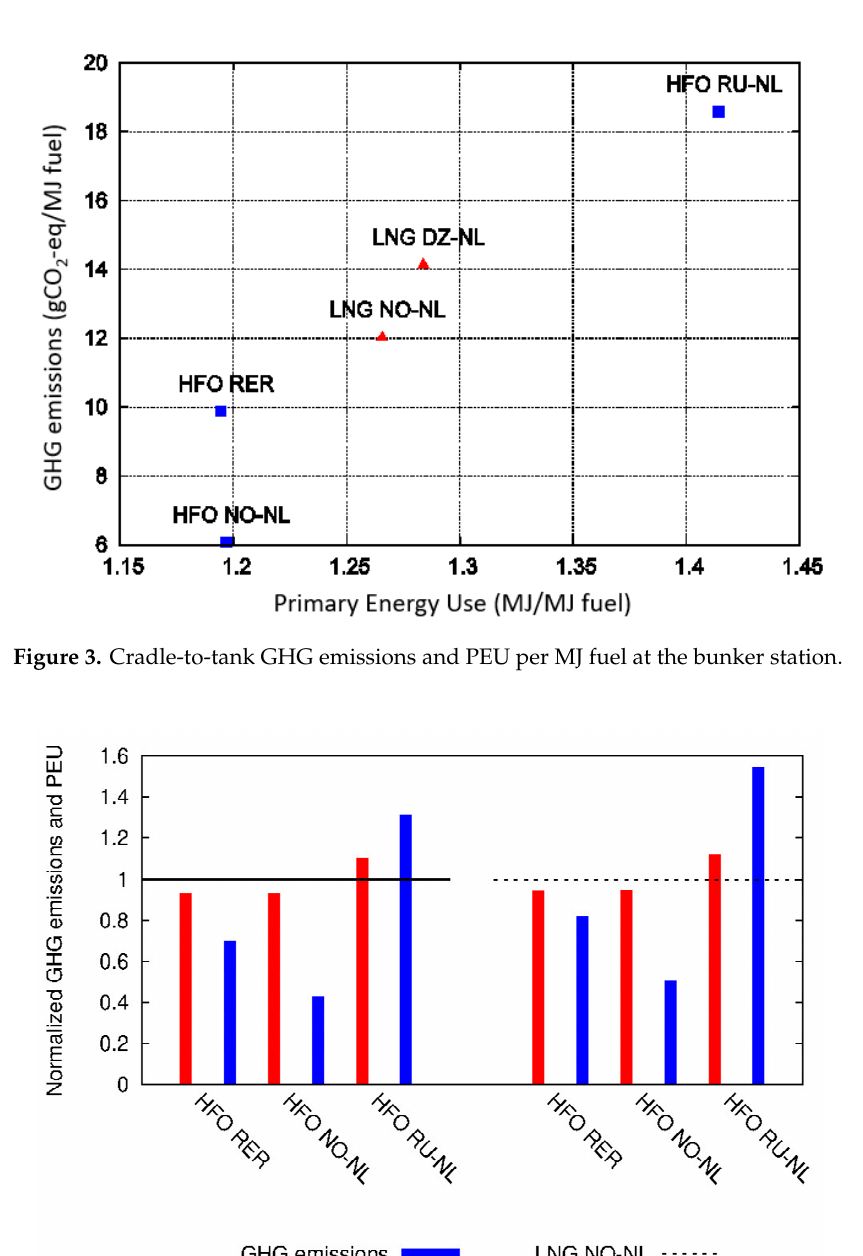
Figure 4. Trends for GHG emissions and PEU for different HFO supply chains normalized by the related LNG supply chain outputs.